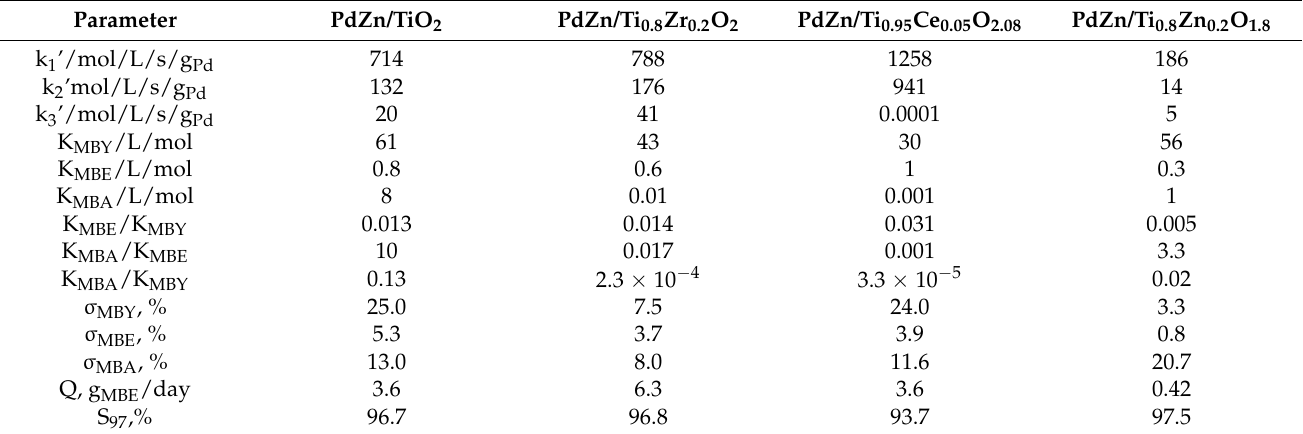
Table 3. Kinetic parameters of the hydrogenation reaction of MBY on films PdZn/Ti x M 1-x O 2 (M = Zr, Ce, Zn) at 28 h on